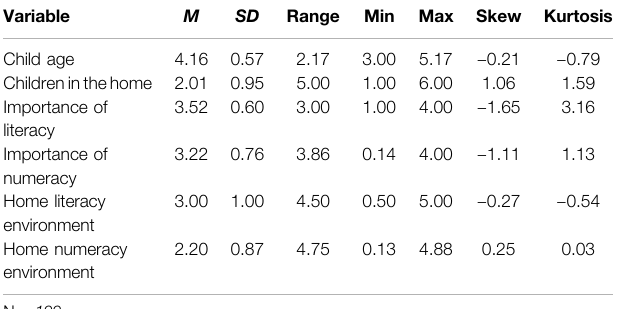
TABLE 4 | Multiple regression analysis predicting home numeracy environment controlling for